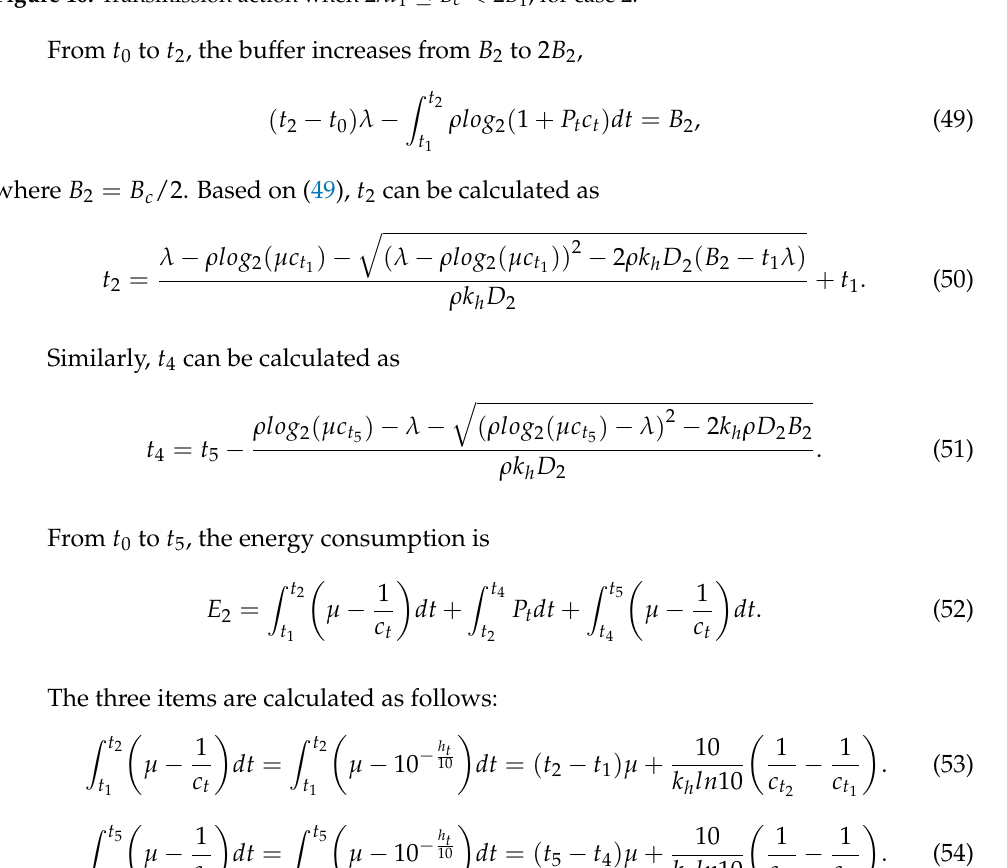
Figure 10. Transmission action when 2 λ t 1 ≤ B c < 2 B 1 , for case